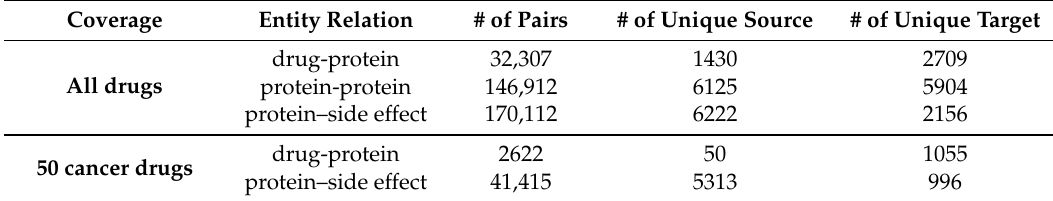
Table 2. Number of pairs, source, and target depend on each entity relation.